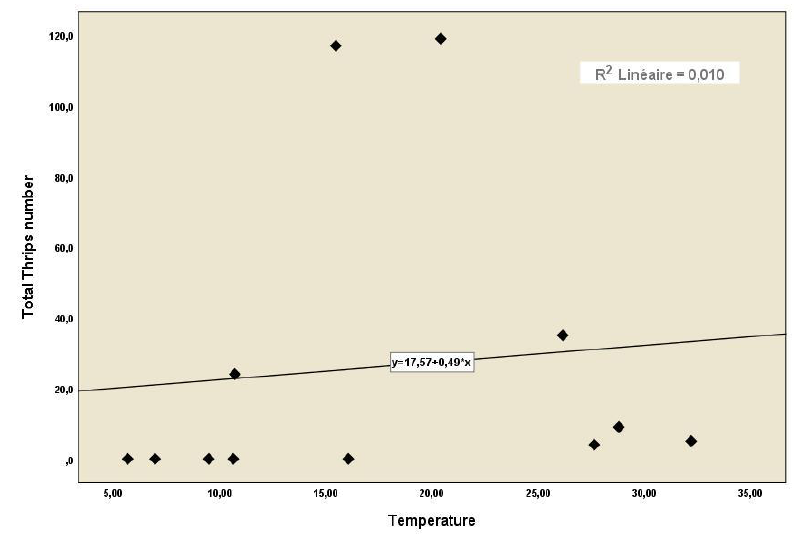
Figure 5. Thrips numbers relationship with temperatures average in Batna region.